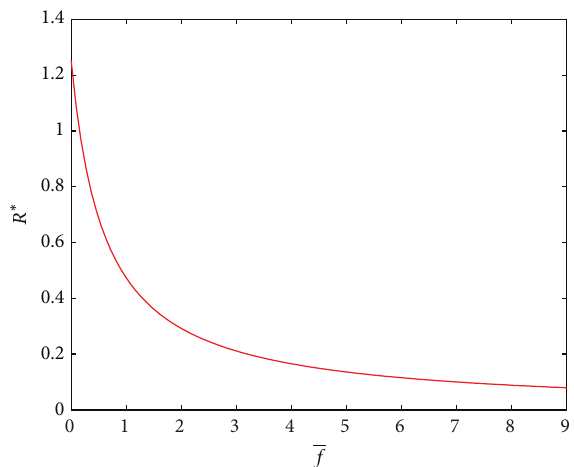
parameters that control disease in an eco-epidemiological system. The graph for the relation of the basic reproduction ratio to 𝛽 is obtained (see Figure 3).